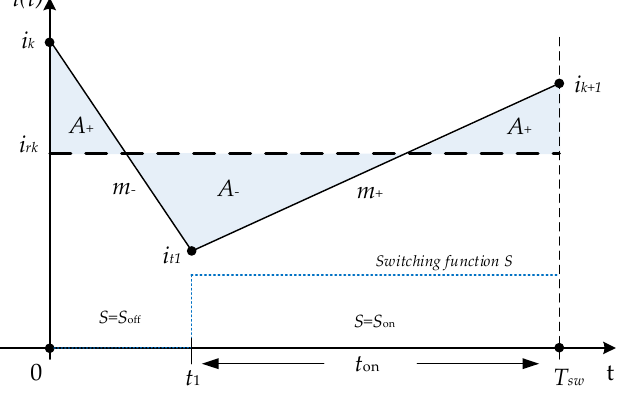
Figure 5. Time evolution of current i ( t ) with respect to t on .